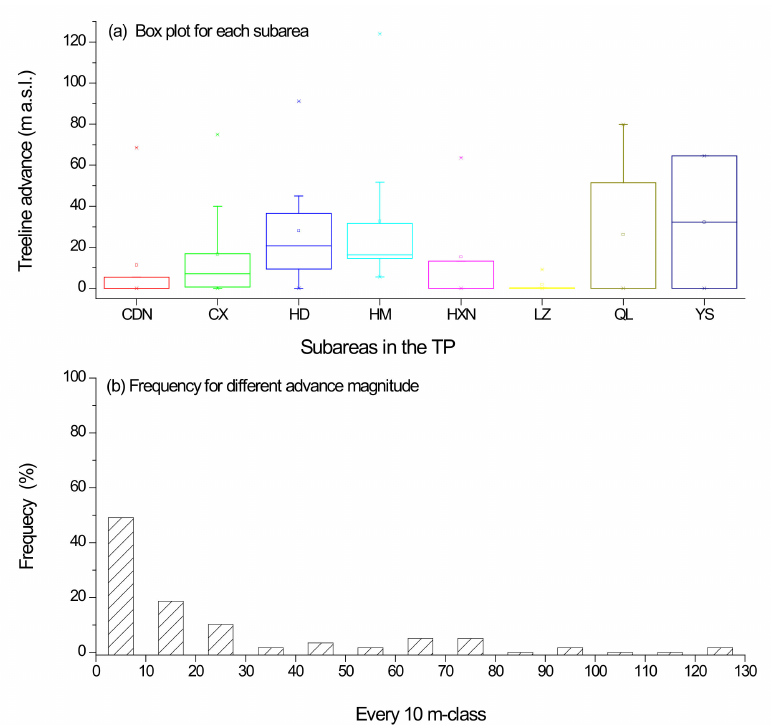
Figure 3. Box plots of treeline advance over the past century for different subareas ( a ) and the frequency of different advance magnitudes (10 m class) ( b ) on the TP. The eight subareas include Hengduan Mountains (HD), Chuangxi region (CX), Linzhi region (LZ), Changdu-Naqu region (CDN), Yushu region (YS), Haixi-Hainan region (HXN), Qilian Mountains (QL) and Himalaya Mountains